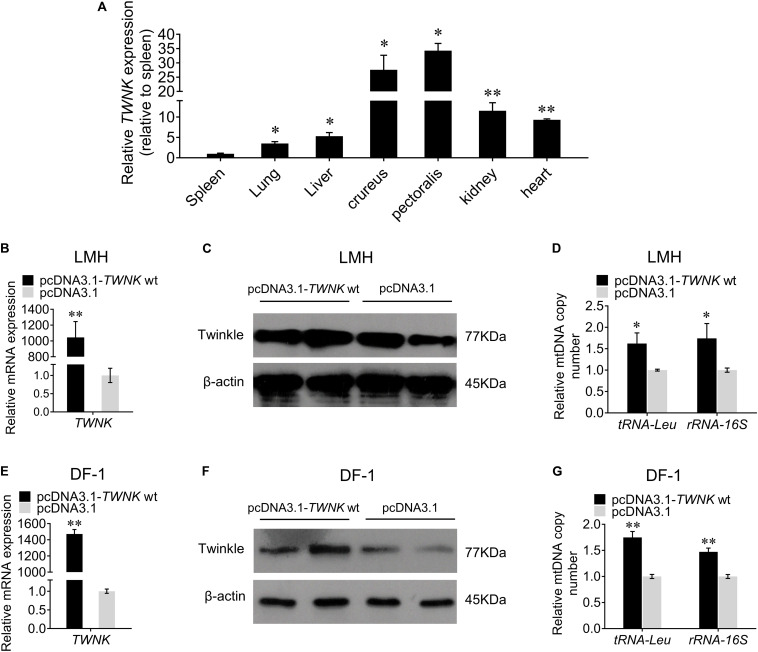
Overexpression of the TWNK increases the mtDNA copy number in vitro. (A) Relative TWNK mRNA expression in chicken tissues. Transfection efficiencies were measured by qRT-PCR at 48 h after transfection with TWNK overexpression in chicken hepatoma (LMH) cells (B) and DF-1 cells (E), respectively. The protein expression levels of Twinkle were measured by western blot at 48 h after transfection with TWNK overexpression in LMH cells (C) and DF-1 cells (F). The relative mtDNA copy number was measured by qRT-PCR at 48 h after transfection with TWNK overexpression in LMH cells (D) and DF-1 cells (G), respectively. The relative mtDNA copy number was represented by the change of tRNA-Leu and rRNA-16S normalized to β2M. Data are presented as mean ± SEM. *p < 0.05, **p < 0.01.